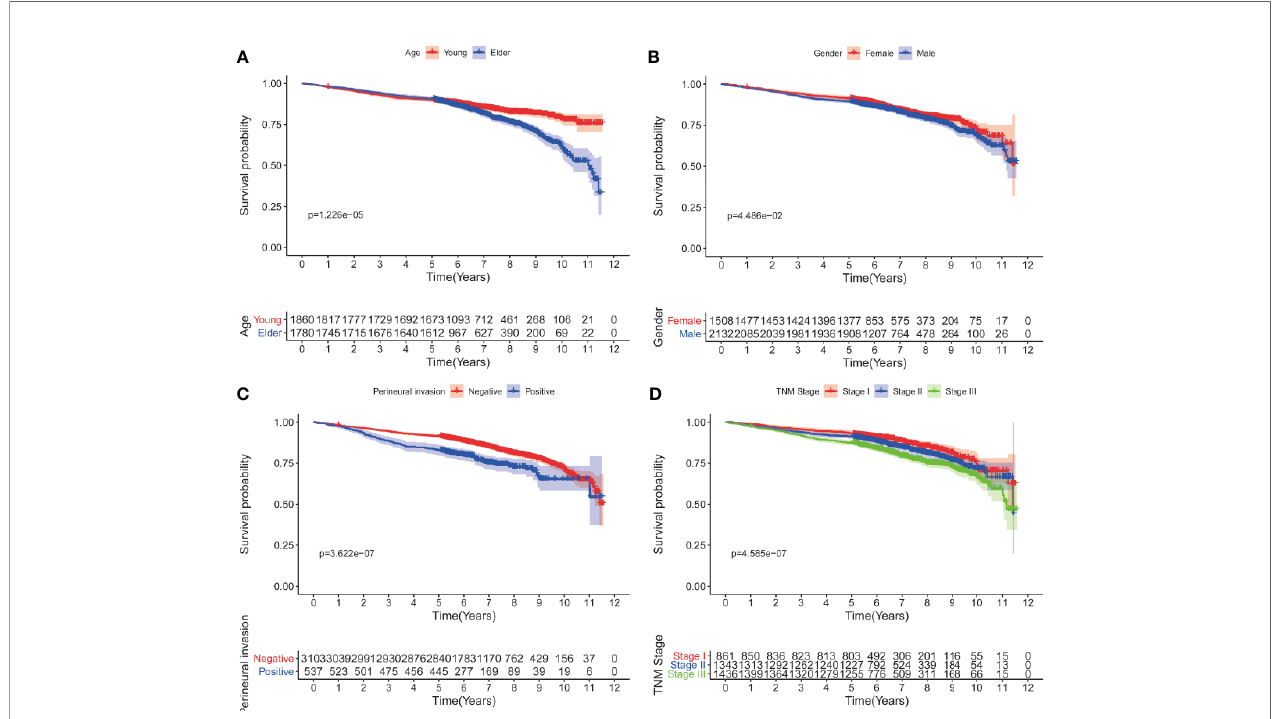
FIGURE 1 | Kaplan-Meier curves for DFS after fi ve years according to clinicopathological factors. (A) age; (B) gender; (C) perineural invasion; (D) pathological stage.